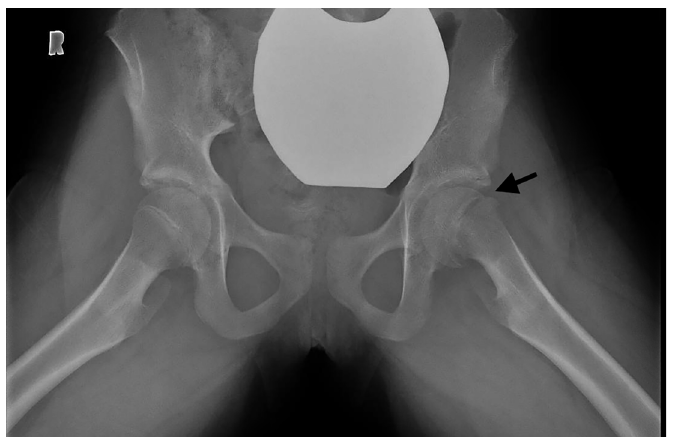
Image 3. Radiograph of pelvis showing medially displaced left femoral epiphysis